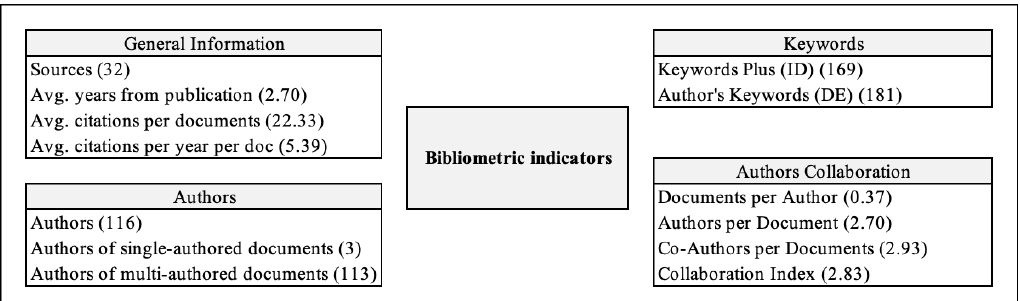
Figure 4. Bibliometric indicators.